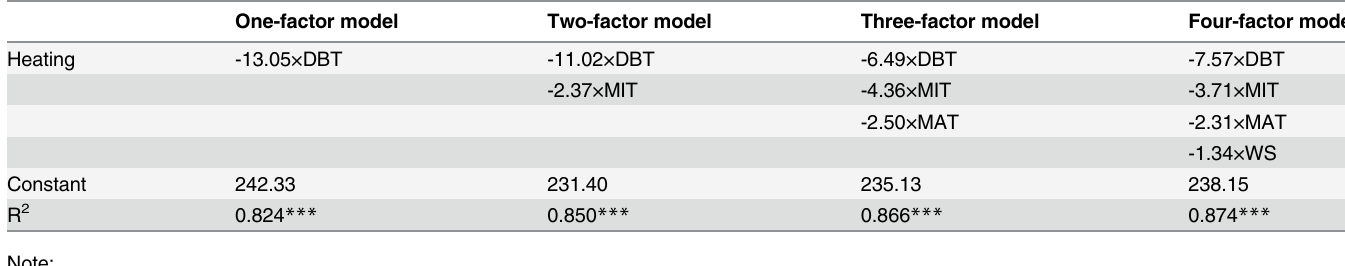
Table 5. Regression analysis for daily extreme energy consumption of residential building against the climatic